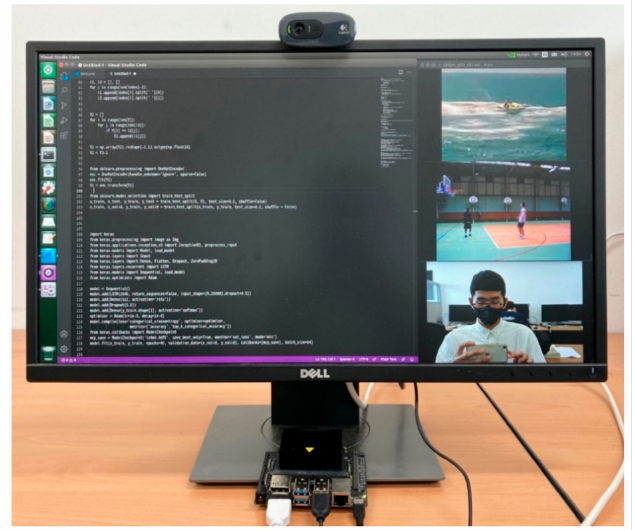
Figure 5. The proposed Jetson NANO-based HAR system